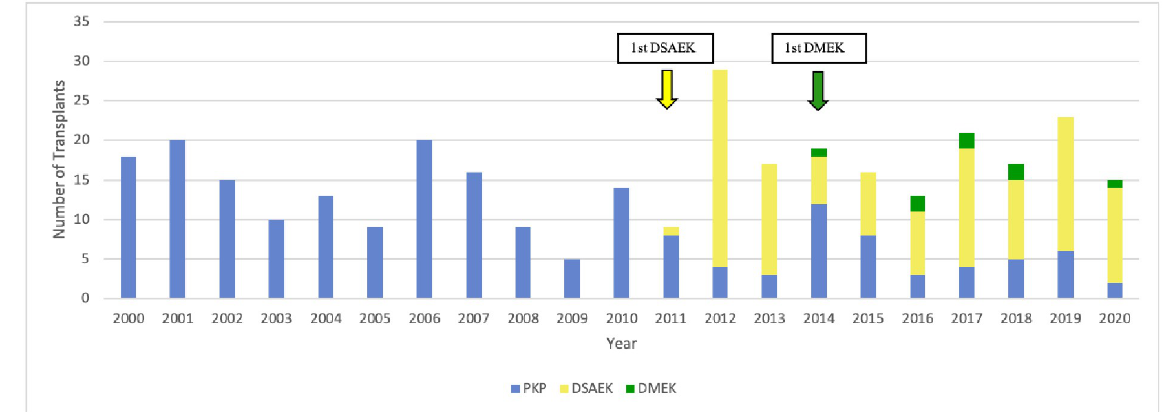
Fig 3. Changes over time in the type of surgery used for PBK. DSAEK, Descemet stripping automated endothelial keratoplasty; DMEK, Descemet membrane endothelial keratoplasty; PKP, penetrating keratoplasty.